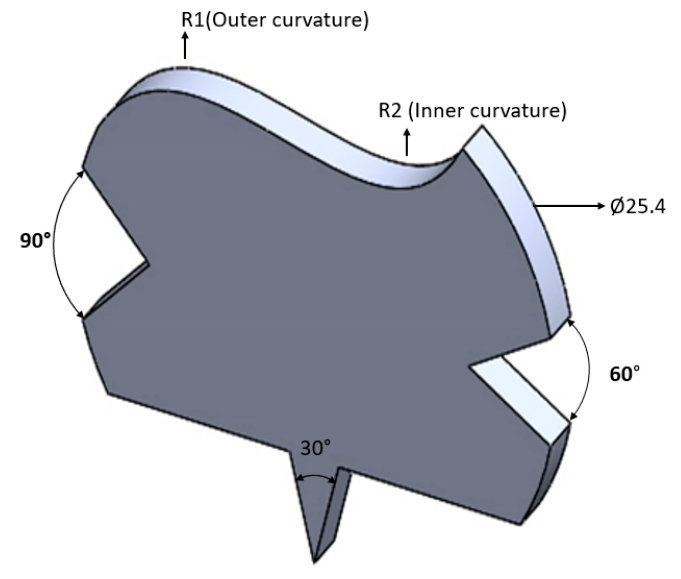
Figure 2. Tool g eometry .